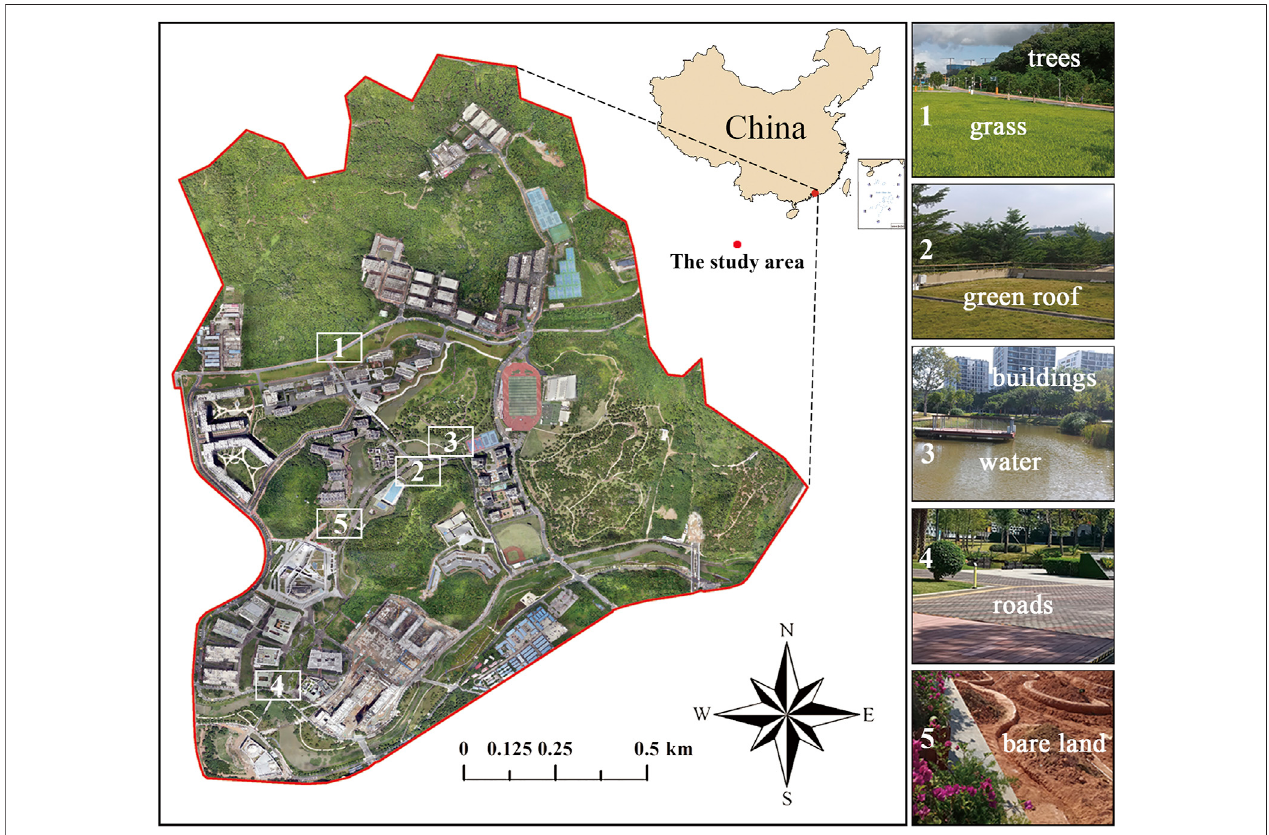
FIGURE 1 | The orthophoto map of study area. The numbers 1 – 5 show the locations of typical infrastructure in the campus, which corresponding pictures are displayed on the right.